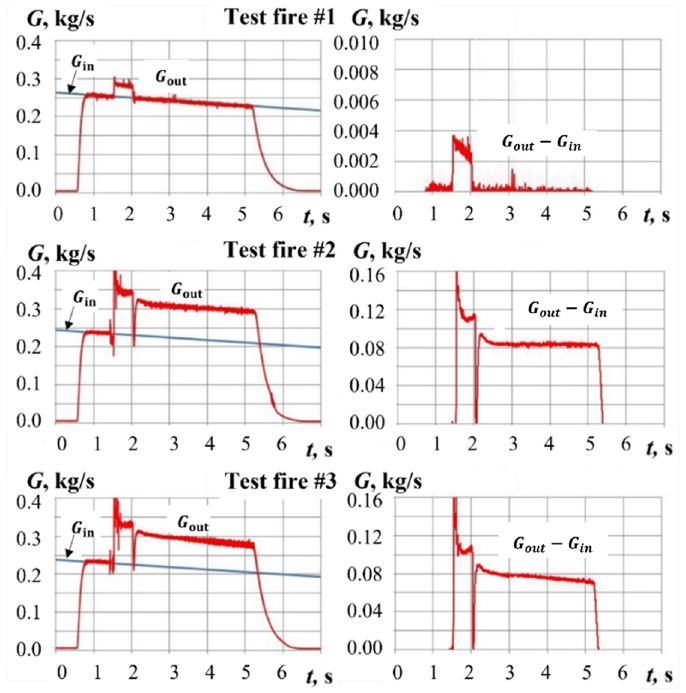
Figure 12. Calculated mass flow rates G in ( t ), G out ( t ), and G out ( t ) − G in ( t ) in test fires #1 to #3.